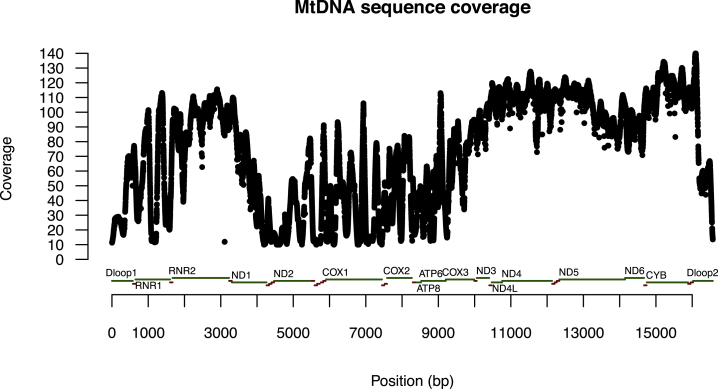
Accessibility of mtDNA for Variant CallingMean per site read depth across 10,442 samples for all sites on the mtDNA. Reads included in the per site read count have passed the following quality control criteria: (1) mapping quality >59, (2) both ends of paired-end read map uniquely to the mtDNA reference NC_012920.1, (3) they do not contain mismatches to the mtDNA reference with total length of 5 bp or above, and (4) base at site in question has base quality of higher than 20. Sites with more than 10% samples with read depth less than 10 would not be used for calling homoplasmic variants, and sites with more than 10% samples with read depth less than 50 would not be used for calling heteroplasmic variants. See also Experimental Procedures.